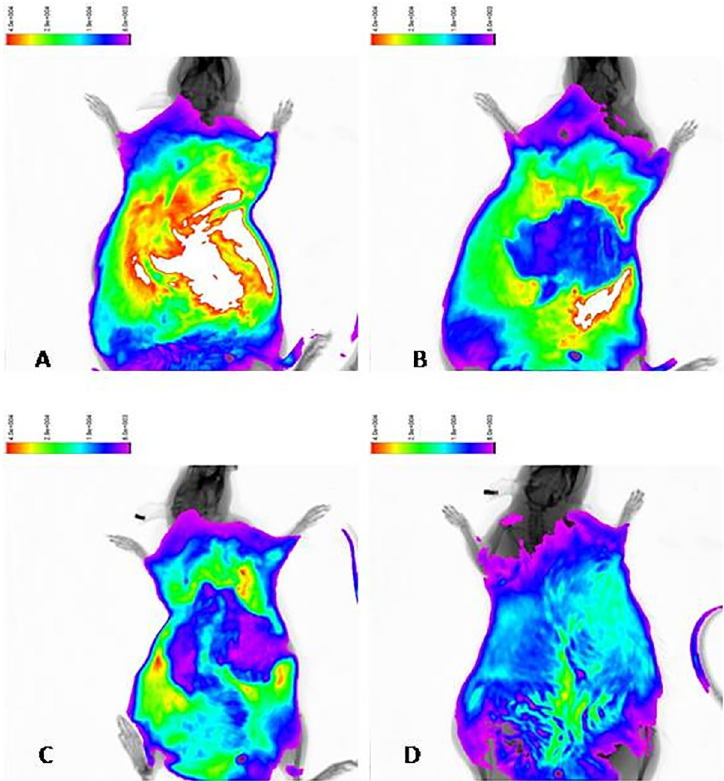
Fig 4. Results of fluorescence imaging performed at (A) week 2, (B) week 6, and (C) week 12 after injections of AAV-T β R1 indicate fluorescence signals of high intensity in the liver. (D) No fluorescence signal was emitted in the control group after injections with saline